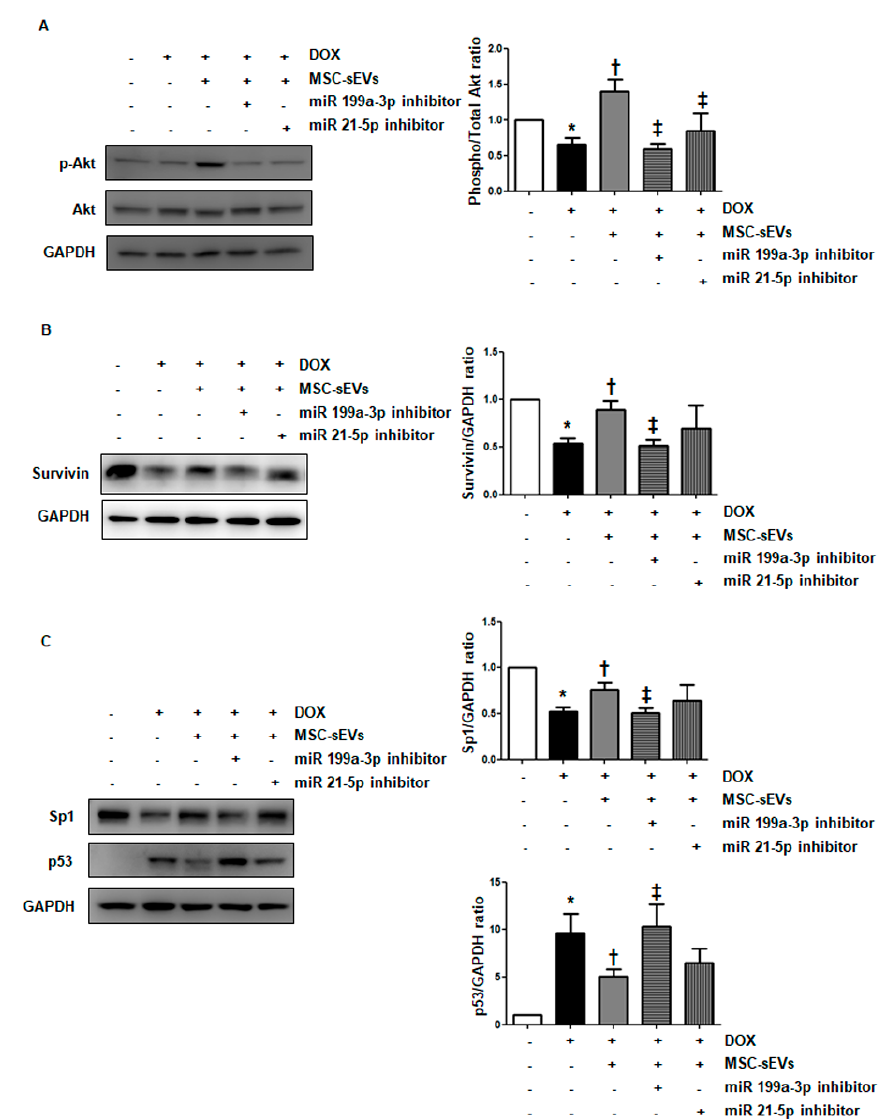
Figure 7 . Inhibition of miR − 199a − 3p alleviates the effects of MSC − sEVs on the Akt − Sp1/p53 − survivin axis in DOX − treated cardiomyocytes. For inhibition of miR − 199a − 3p and miR − 21 − 5p, H9c2 cells were transfected with miRNA inhibitors (100 nM) targeting each miRNA. ( A ) After treatment with MSC − sEVs (3 × 10 9 ) for 1 h, cells were treated with DOX (1 μ M) for 8 h. The protein levels of p − Akt, Akt, and GAPDH were measured by Western blotting ( n = 5). ( B , C ) H9c2 cells transfected with miRNA inhibitors were pre − treated with MSC − sEVs (3 × 10 9 ) for 24 h, and then incubated with DOX (1 μ M) for another 24 h. The protein levels of survivin, Sp1, p53, and GAPDH were measured by Western blotting ( n = 5). * Significant difference compared to the control ( p < 0.05). † Significant difference compared to DOX treatment ( p < 0.05). ‡ Significant difference compared to MSC − sEVs + DOX treatment ( p < 0.05).